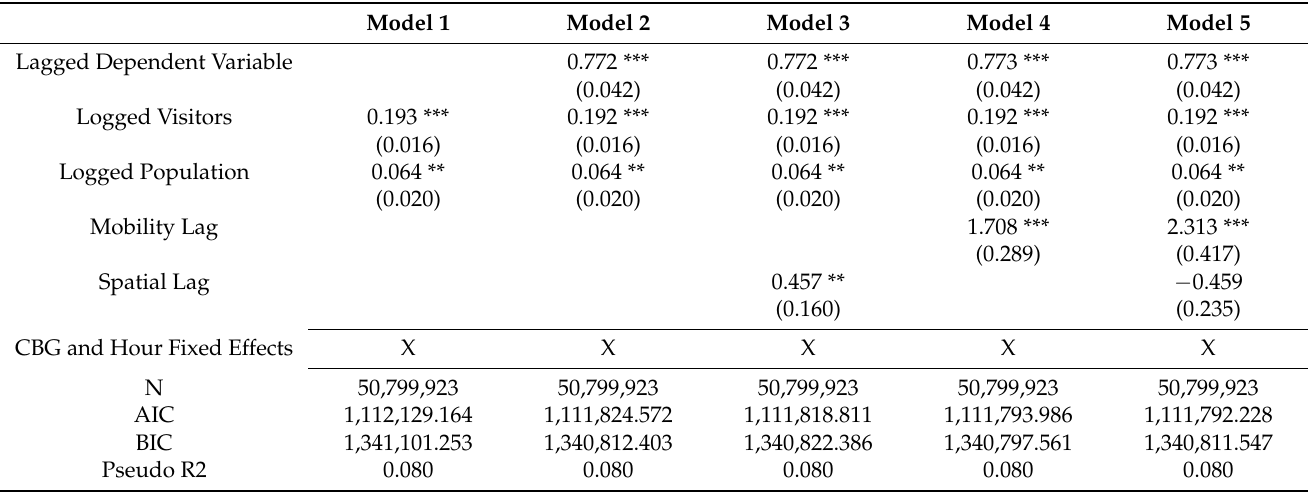
Table 4. New York City Hourly Violent Crime